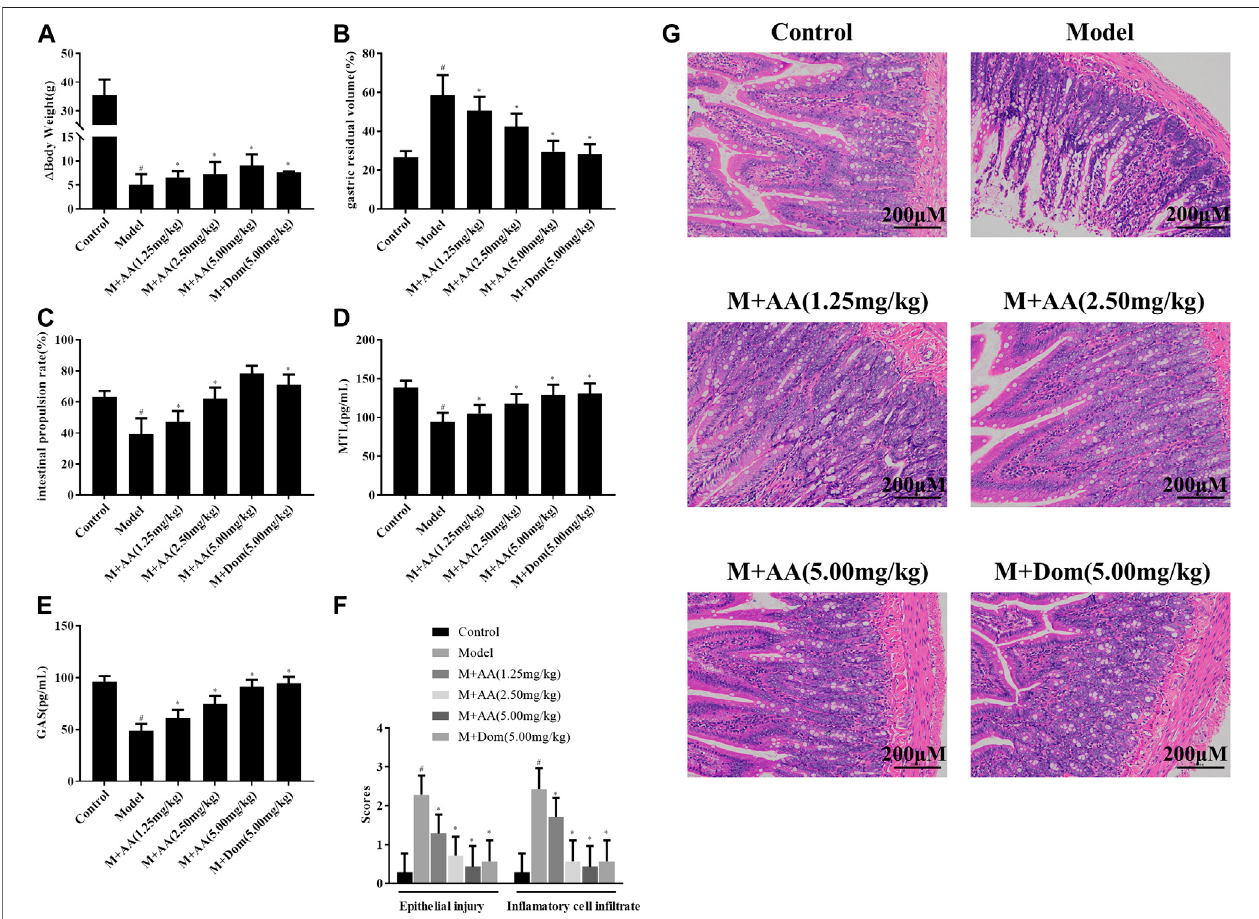
FIGURE 2 | Effects of AA on Δ body weight, gastric residual volume, intestinal propulsion rate, and levels of gastrointestinal motility hormones in spleen de fi ciency syndrome rats ( n (cid:2) 10). Histopathological evaluation of the intestine of SDS rats treated with AA. M + AA: SDS model rats administrated with AA. (A) Δ body weight, (B) gastricresidualvolume, (C) intestinalpropulsionrate, (D) serumgastrinlevels, (E) motilinlevels, (F) epithelialinjuryandin fl ammatorycellin fi ltrationintointestinetissuesof control,model,AA,andM+AAgroups, n (cid:2) 6pergroup,and (G) representativeimagesofHE-stainedsections(200 × magni fi cation)showingpathologicalchanges in SDS rats after treatment with low (1.25 mg/kg), middle (2.5 mg/kg), or high (5 mg/kg) doses of AA or with Dom (5 mg/kg). Data represented mean ± SD. Results are expressed as the mean ± SD from at least three independent experiments. * p < 0.05, compared with model; # p < 0.05, compared with control.